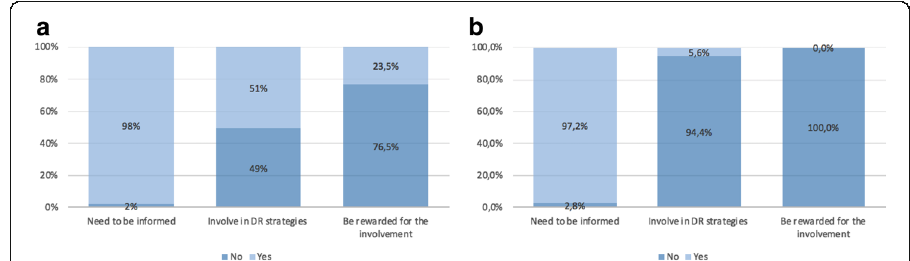
participation in the DR program. N = 36